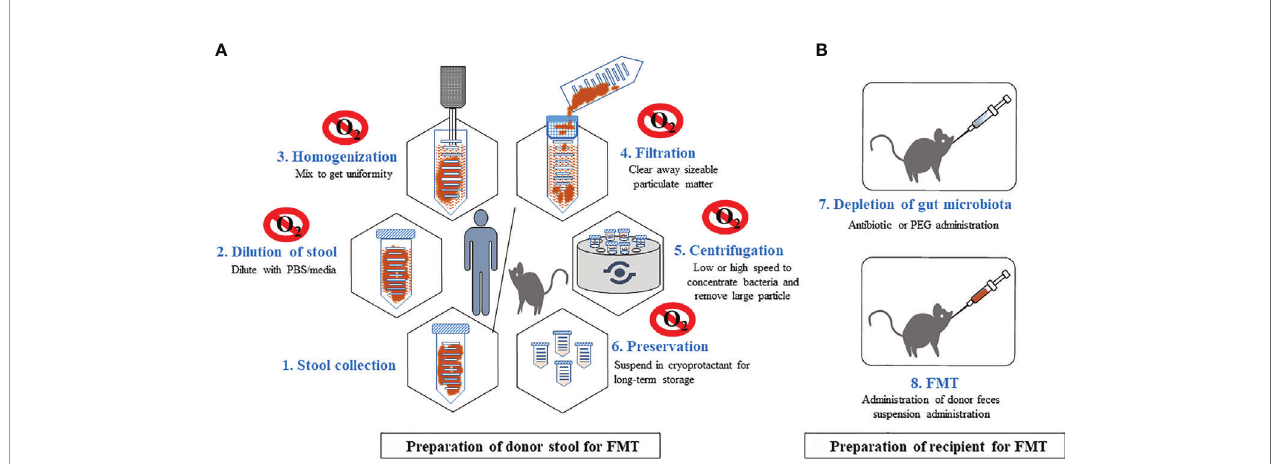
FIGURE 1 | General procedures for FMT in murine. Step-wised procedures of FMT from human or mice donors to mice recipients. This includes preparation of donor stool (A) and preparation of recipients (B) . Preparation of donor stool is recommended in anaerobic environment. Raw stools will be diluted, homogenized, fi ltered, followed by centrifuge to remove large particles. Processed stool can be stored in long term in -800C. Recipient mice will treated with antibiotics or PEG to deplete the majority of the gut microbiota, providing an ecological niche for colonization of transplanted stool